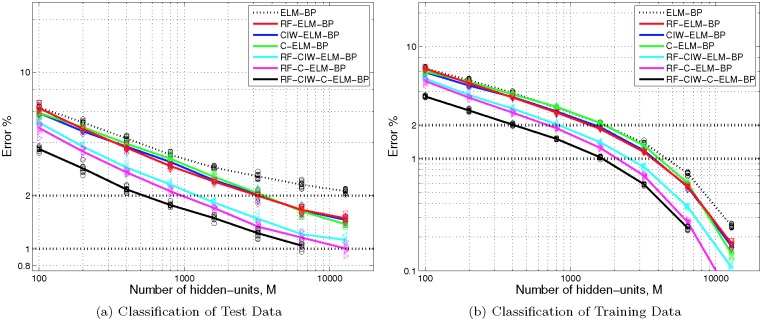
ELM-backpropagation error rates for MNIST for various SLFN ELM methods with shaped input weights.Each trace shows the mean error percentage from 10 different trained networks applied to classify (a) the 10000-point MNIST test data set, and (b) the 60000-point MNIST training data set used to train the networks, for various different sizes of hidden layer, M, when ten iterations of backpropagation were also used. Markers show the actual error percentage from each of the 10 networks. In comparison with Fig 3, it can be seen that backpropagation significantly improves the error rate for small M with all methods, but has little impact when M = 12800. The total number of hidden units used for RF-CIW-C-ELM is actually 2M+500, but each parallel ELM has M hidden-units.